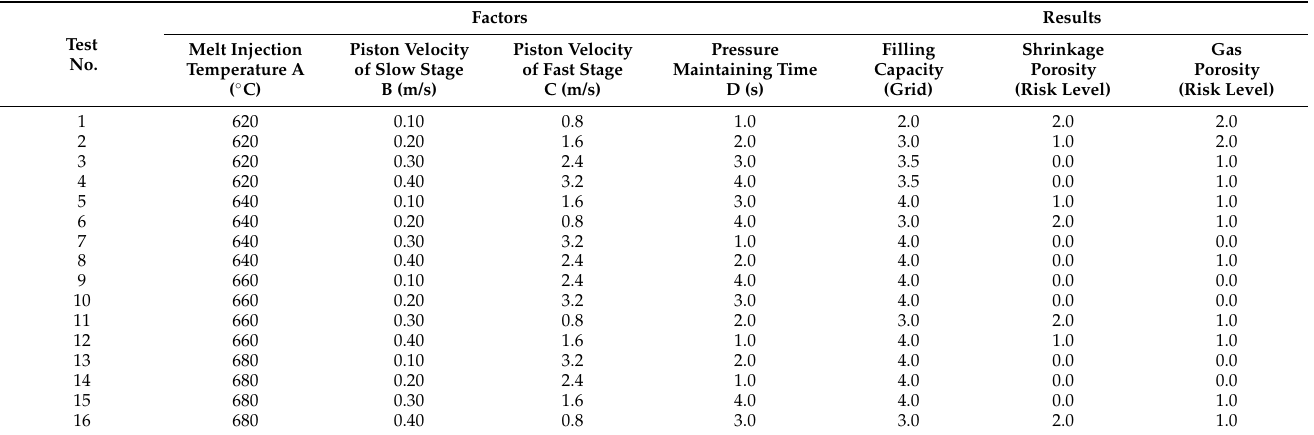
Table 4. The process plan and results of orthogonal experiments.